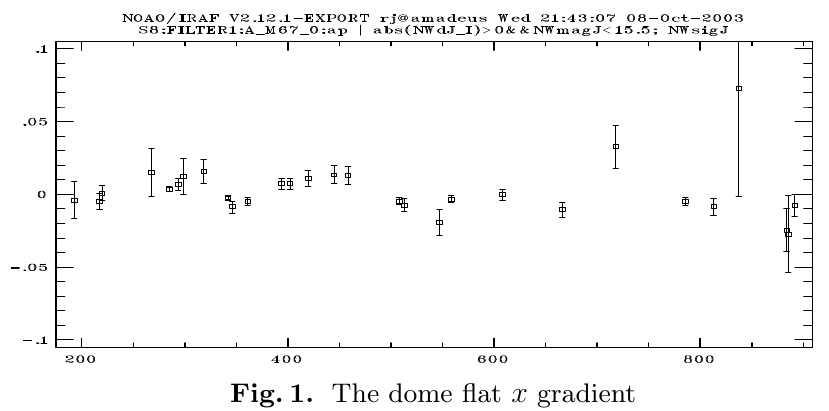
Fig. 1. The dome flat x